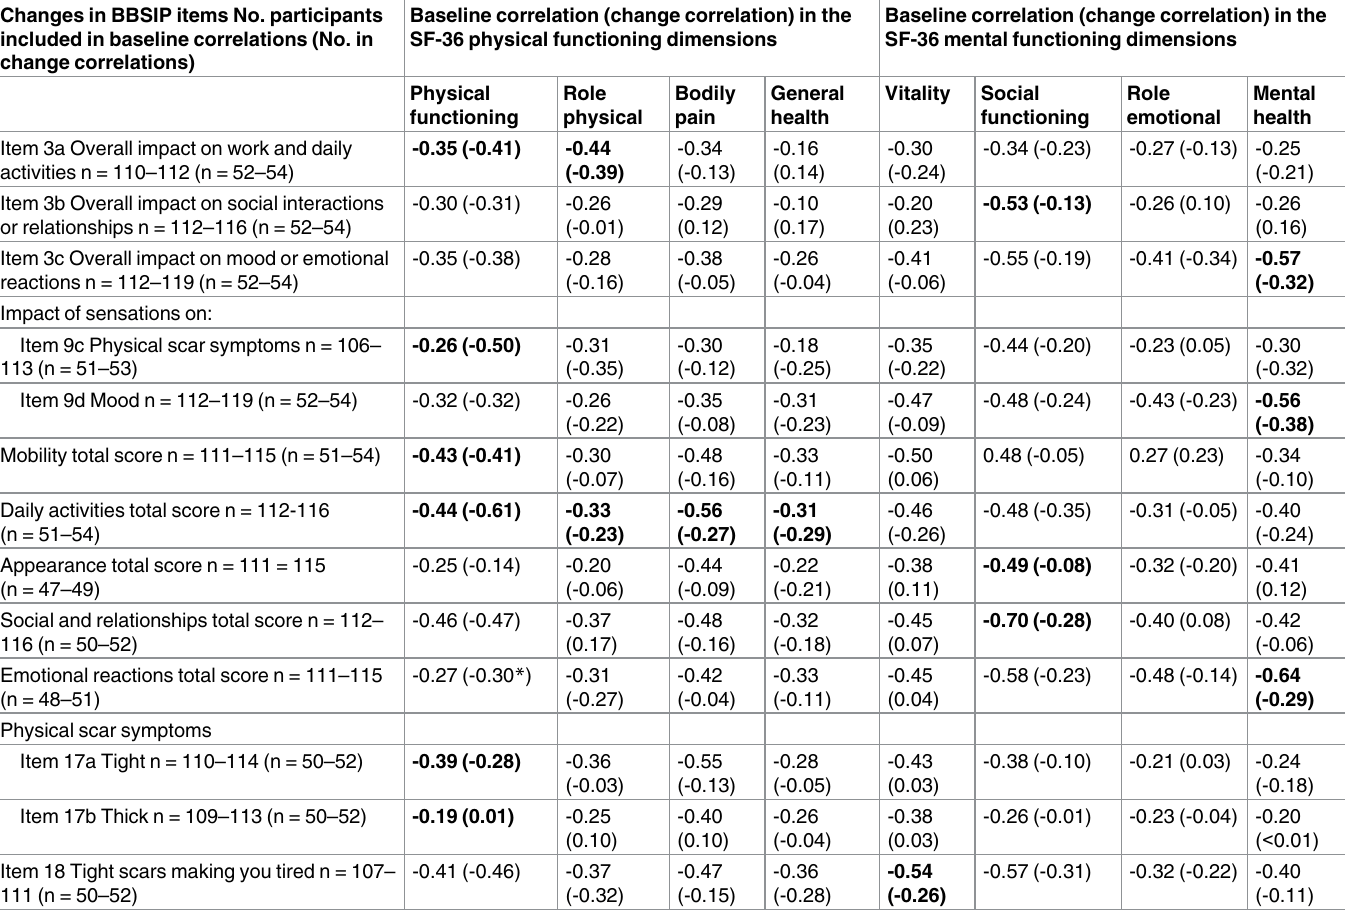
Table 3. Correlations between changes in BBSIP items and changes in SF-36 dimensions between baseline and 1-month follow-up a . Changes in BBSIP items No. participants included in baseline correlations (No.